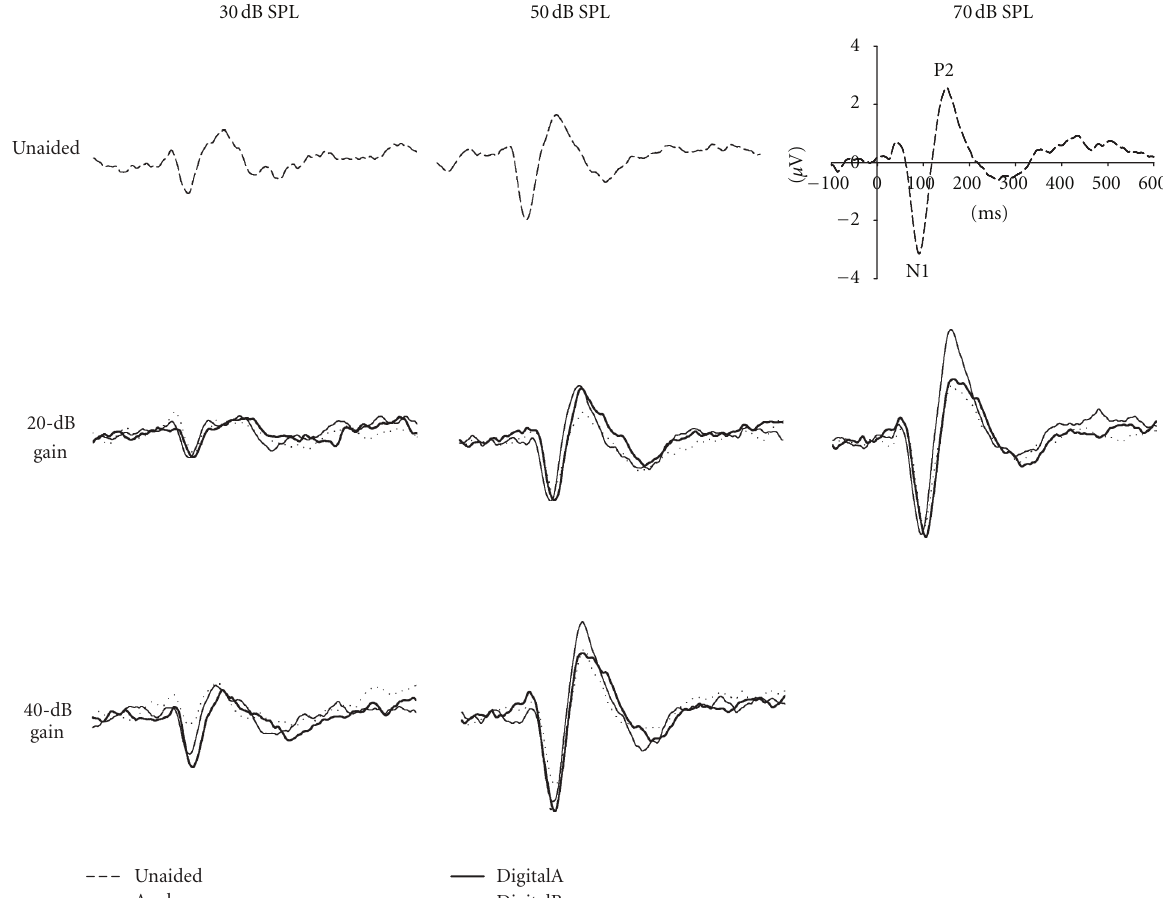
Figure 1: Grand mean ( N = 13) waveforms from electrode Cz for unaided and aided conditions (Analog, DigitalA, and DigitalB) with two gain settings (20 and 40dB) at three input levels (30, 50, and 70 dB SPL).